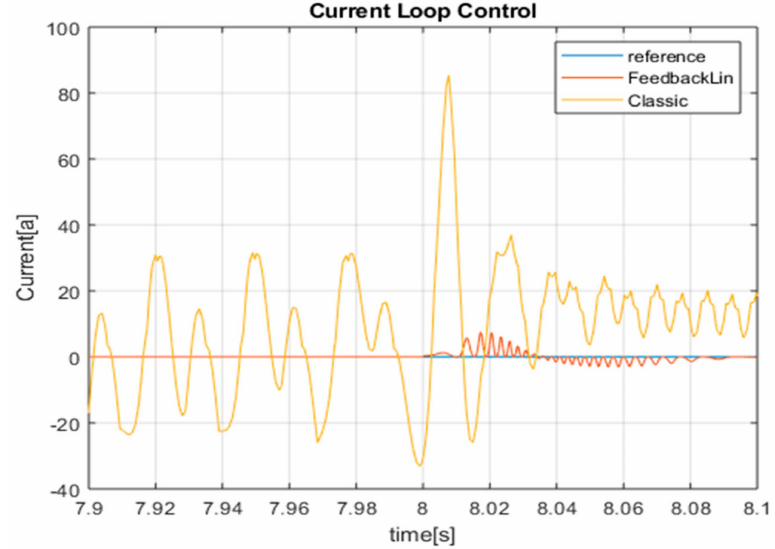
Figure 11. A detail of the current trajectory tracking to highlight the ability of the nonlinear control to reduce the oscillation e ff ect due to the cogging